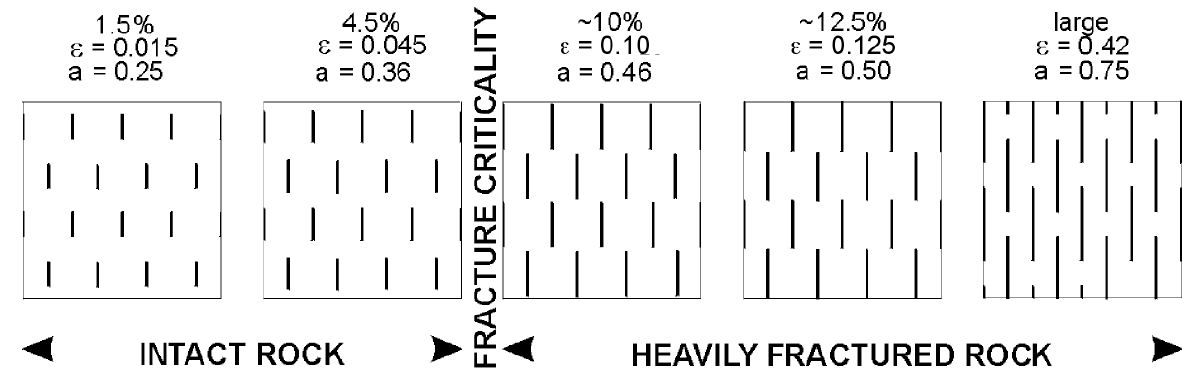
! Figure 2. Schematic dimensionless illustrations of the observed percentages of shear-wave velocity-anisotropy interpreted as uniform distributions of equal-sized parallel penny-shaped cracks with the same percentage anisotropy, where f is crack density, and a is crack radius per unit cube. Fracture criticality is at the percolation threshold of f = 0.055 for parallel cracks, where cracks are so closely spaced they fracture if there is any disturbance. [After Crampin 1994].